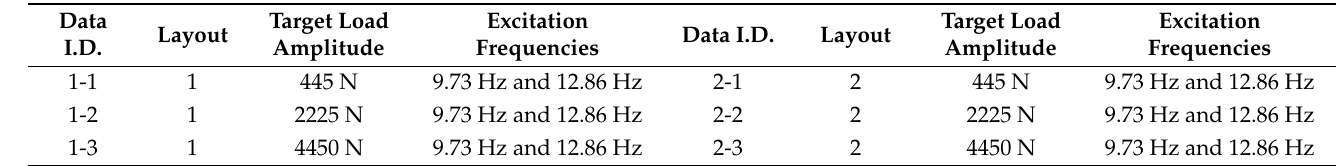
Table 4. Field experimental data used for the Bayesian FE mode updating. The measured data with excitation frequencies close to mode 1 and mode 2 are lumped